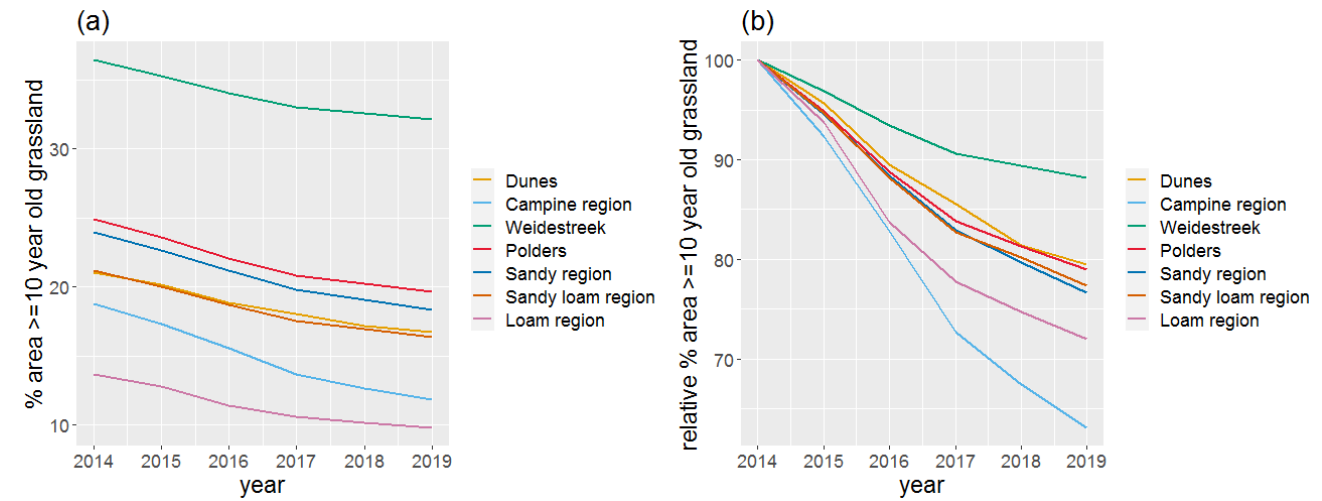
Figure 9 . ( a ) Percentage of long-term grassland aged 10 years or older from 2014 to 2019 in the seven agricultural regions. ( b ) Relative % area change of long-term grassland from 2014 to 2019 in the seven agricultural regions.